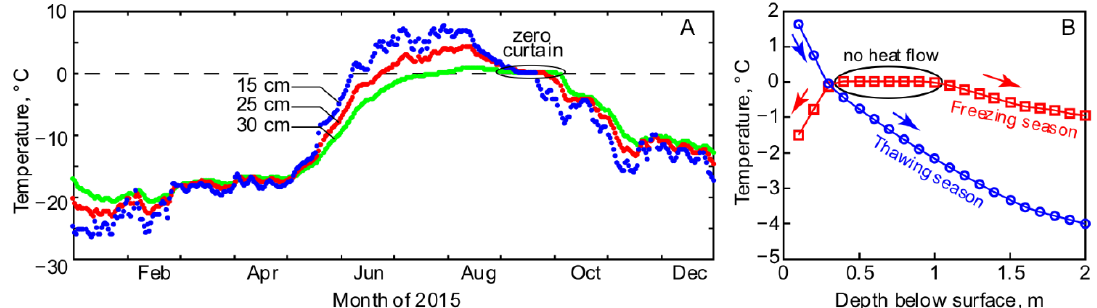
Figure 1. The zero curtain. (A) Daily ground temperatures (2 PM local) measured at various depths in the active layer above permafrost (location at 76.55414° N, 68.561680° W, 190 m asl) near Qaanaaq, Greenland. During 2015, there was a prominent zero-curtain effect due to the phase transition of water in the soil. During this time, the ground temperature was maintained at or near 0 °C at depths of 15 and 25 cm. Deeper than 30 cm the temperature never exceeded freezing, and near the immediate surface (not shown) the ground temperatures were commonly variable due to solar heating of the surface, complicating the effects of wind and cloudiness. This zero curtain was only observed from September to early October, during freeze-up, but not during the spring thaw. Unpublished data from R.S. Sletten. (B) Schematic from Putkonen [12] showing the modeled heat flow during freezing and thawing seasons. During freeze-up (red squares), the soil temperatures at the 0.5 – 1 m depth quickly reaches the freezing point, such that no heat diffusion upward (driven by the temperature gradient) can occur. The zero curtain will be maintained until all water in the active layer freezes. During the thaw (blue circles), the high thermal gradient in the soil ensures efficient heat flow and the soil will consistently warm with no zero curtain.